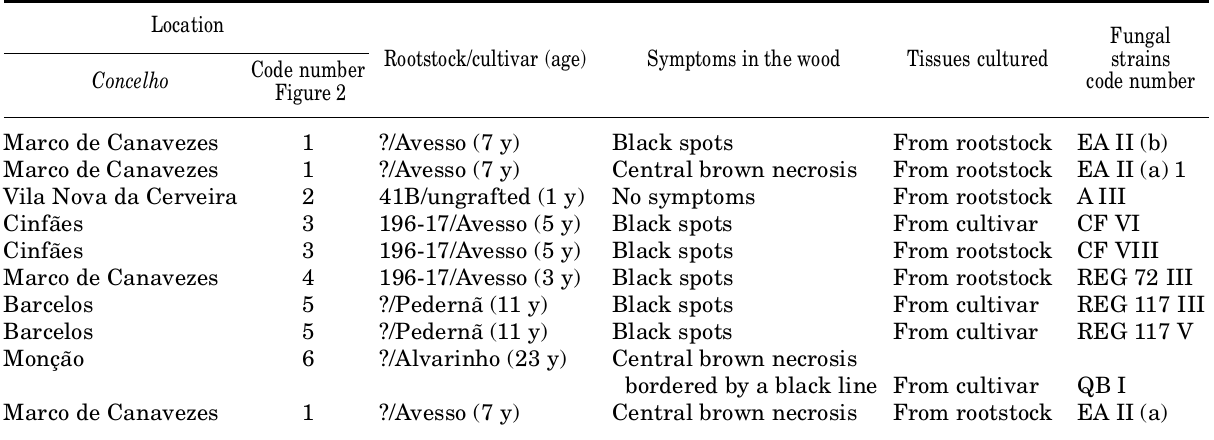
Table 1. Sources of strains recovered from diseased